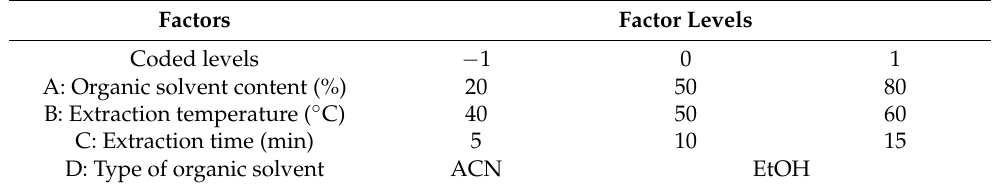
Table 2. Independent factors and their levels that were used in the BBD to optimize the MAE method.